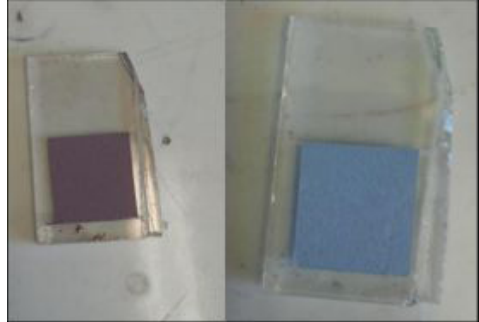
powders with gold nanoparticles, 2